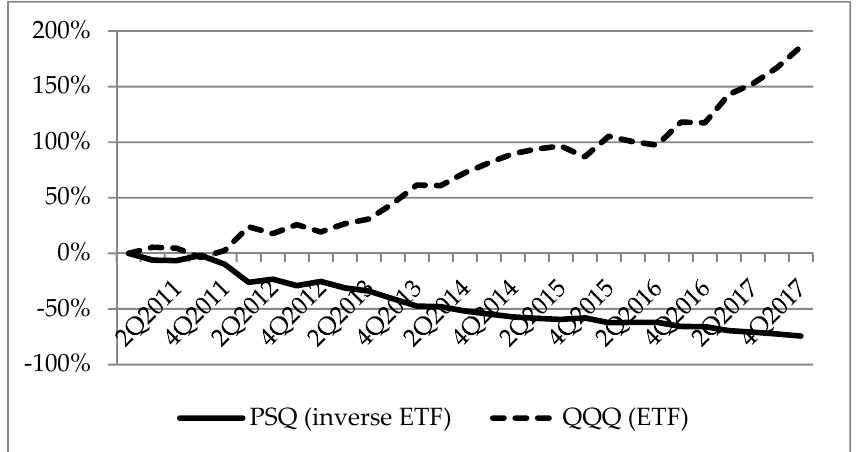
Figure 1. Total return of the exchange-traded fund (ETF) and inverse exchange-traded fund tracking the same reference index Nasdaq 100 Index for the period 2010–2017.